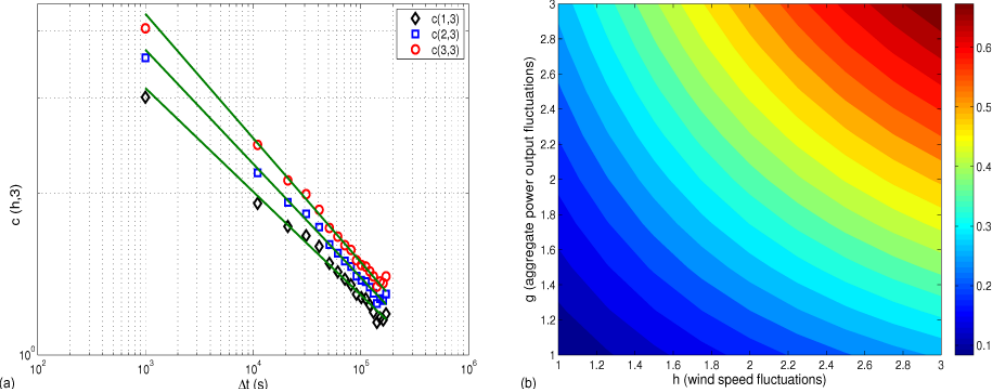
Fig. 8. (a) The generalized correlation functions (GCFs) c(h,g) versus the time increments 1t in log–log plots for simultaneous wind speed and aggregate power output fluctuations. (b) The generalized correlation exponents (GCEs) r(h,g) estimated from the linear regression of c(h,g) .